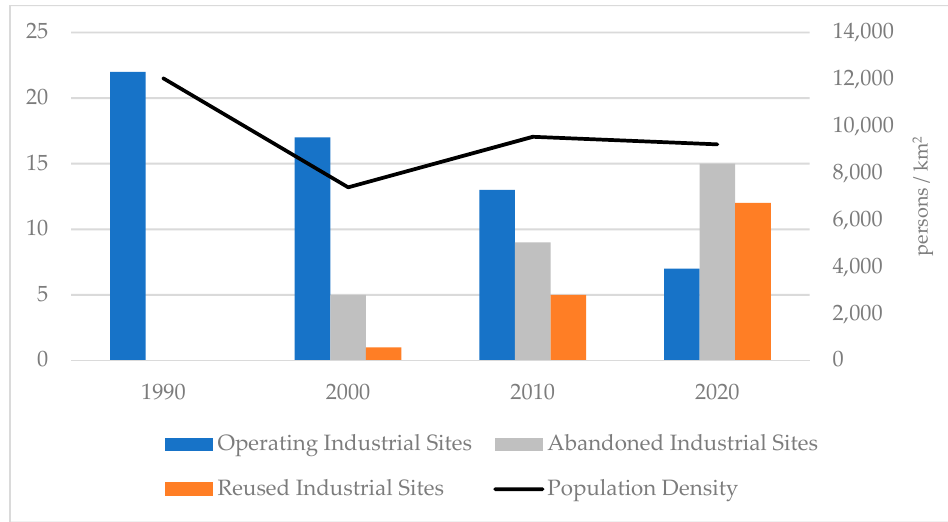
Figure 18. The change in the relationship between the operation state of capital-intensive industries and the population density over time (Figure source: own drawing; data from: [84]).